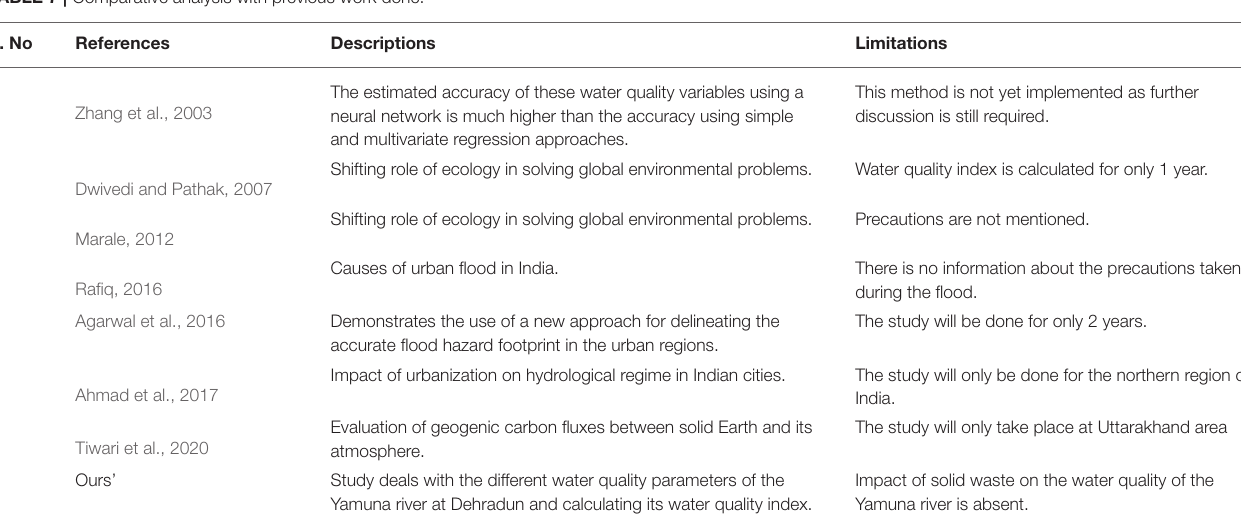
TABLE 7 | Comparative analysis with previous work